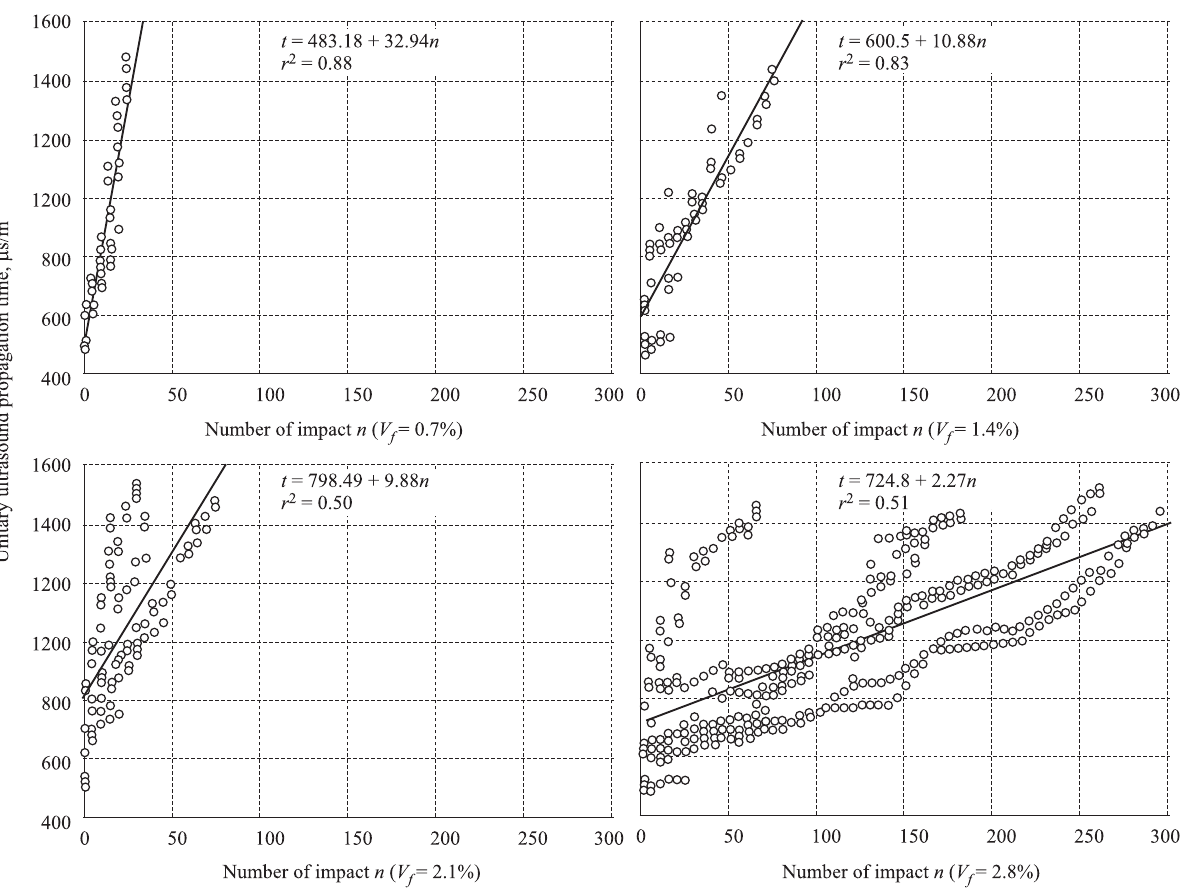
Fig. 5. Unitary ultrasound propagation time, µs/m